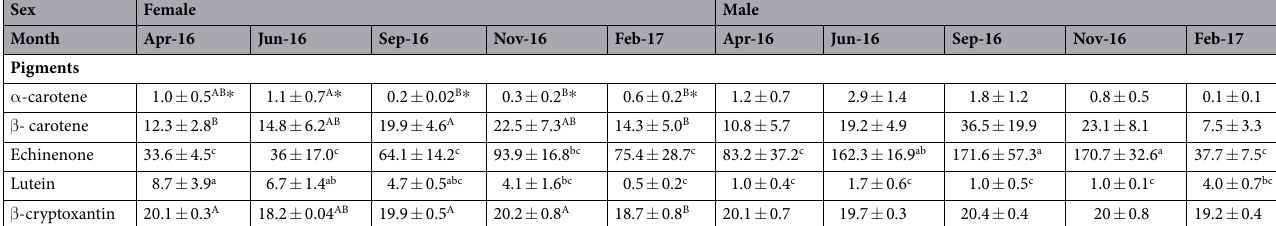
Table 3. Content of carotenoid pigments found in gonads (ovary and testis, µ g.g − 1 WW) of P . lividus collected at Praia Norte (Portugal) at five distinct periods. Values are mean ± standard deviation; per month the 18 individuals were pooled by sex: N = 3 pools of female gonads and N = 3 pools of male gonads were established. Within a row, superscripts in capital letters ( ABC ) indicate significant differences between months, asterisk ( * ) indicate differences between sexes and in lowercase letters ( abc ) indicate significant differences between sex X month ( P < 0.05).